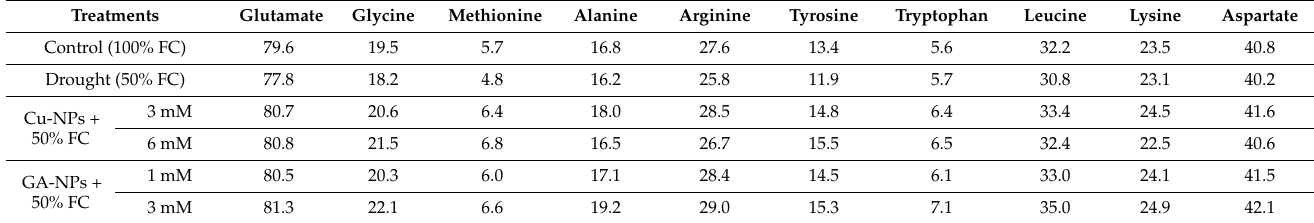
Table 7. Effect of Cu-NPs and GA-NPs on distribution of amino acids (% of dry matter) in soybean seeds under drought stress (50% FC). Each value is the average of both